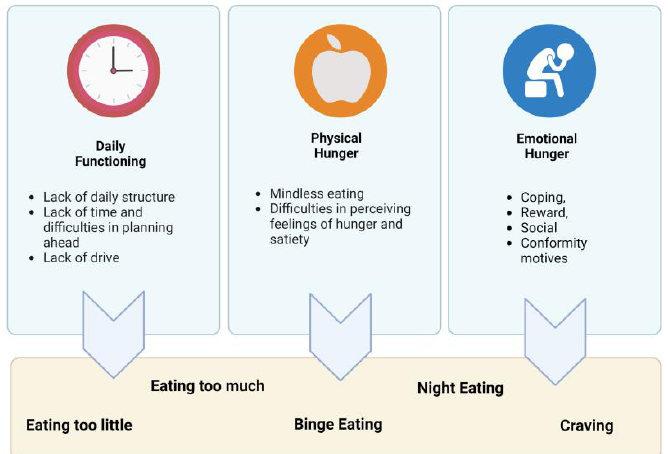
Figure 1. Thematic presentation of experiences with disordered eating patterns and underlying factors as reported from people with serious mental illness This figure was created with BioRen- der.com.